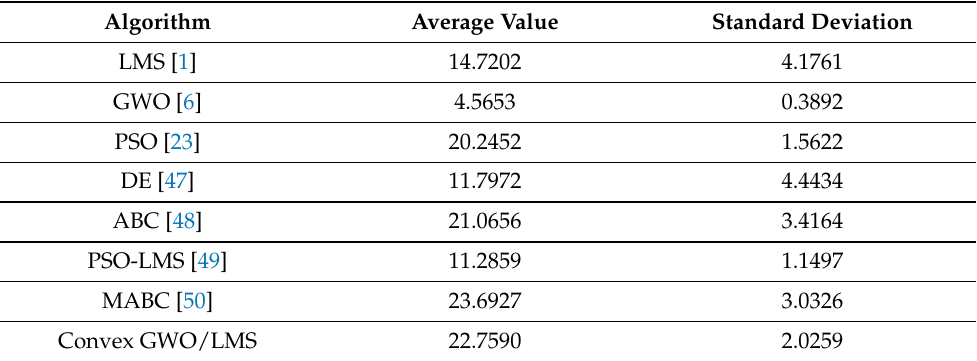
Table 2. Comparison between the proposed convex GWO/LMS system and existing approaches in terms of average value of ERLE and standard deviation in